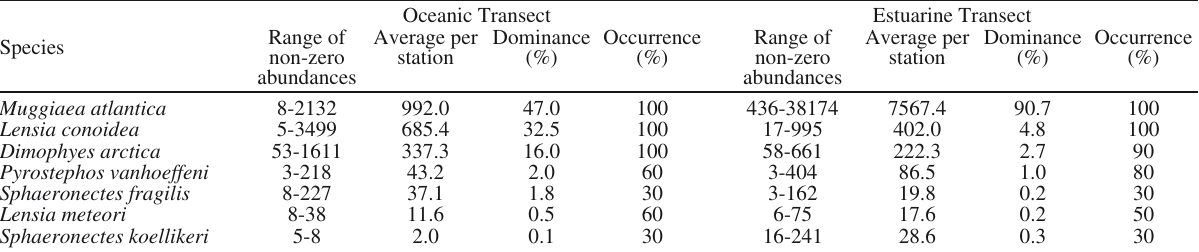
Table 1. The calycophorans Muggiaea bargmannae, Lensia subtilis, Praya dubia and Sphaeronectes fragi- lis are recorded for the first time in this central Chilean phores of M. bargmannae in the Picton Channel (Sta.